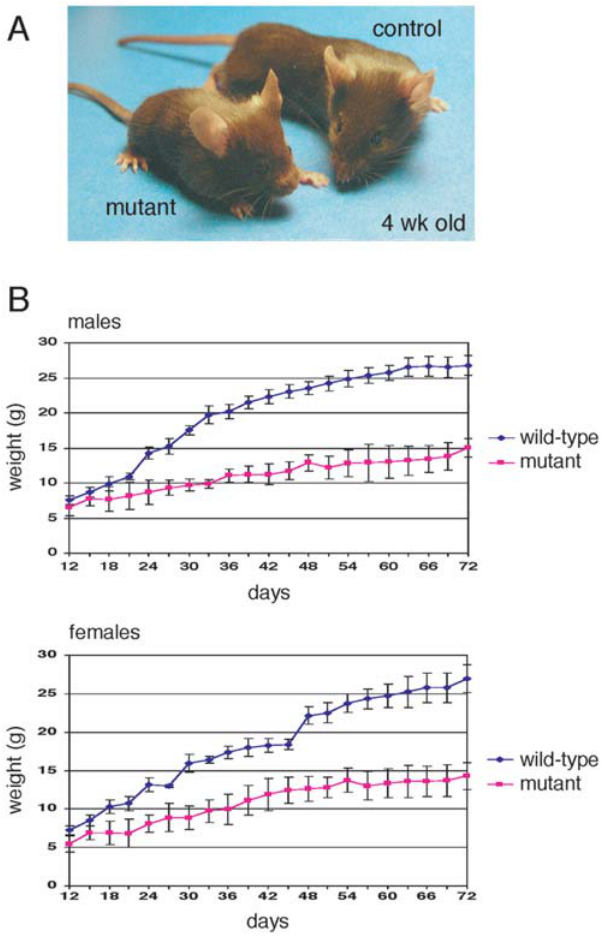
Figure 2. Growth defects in R26 floxneoWnt4 ; Col2a1-Cre mutants. A, 4- week-old R26 floxneoWnt4 ; Col2a1-Cre mutant and control littermates. The mutant has a significantly shorter body and altered head shape relative to the control. B, Mean body weight comparisons 6 standard error between sex-matched mice from 12 to 72 days after birth. n=5 for mutants, and n=6 for controls.